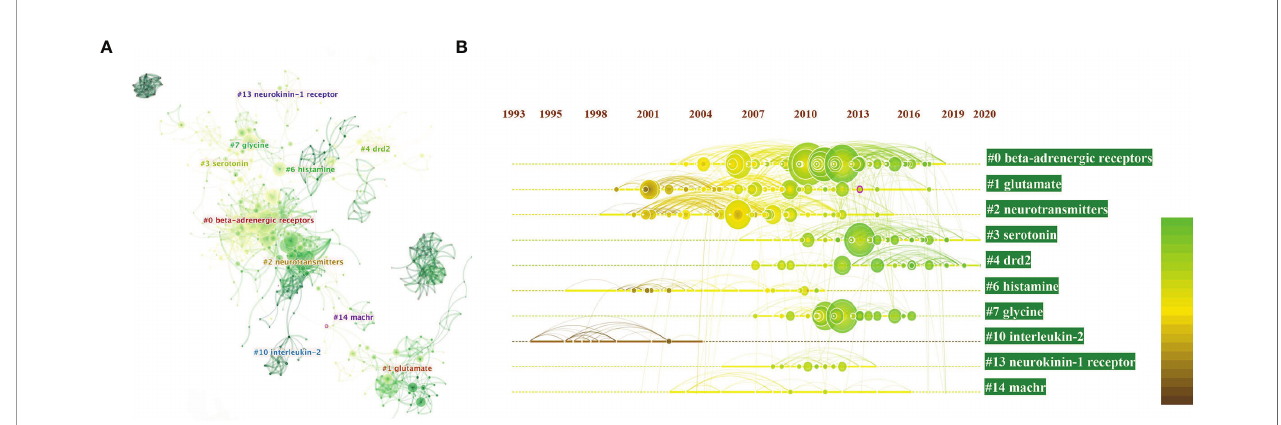
FIGURE 4 | (A) Clustered networks of co-citation status of the investigated 39677 references and the 1285 citing articles via CiteSpace. The top 10 largest clusters of citing articles are shown; (B) Timeline view of the top 10 largest clusters of citing articles in the fi eld of neurotransmitters and tumor progression research. Machr also known as nAchRs. Right side = cluster labels.